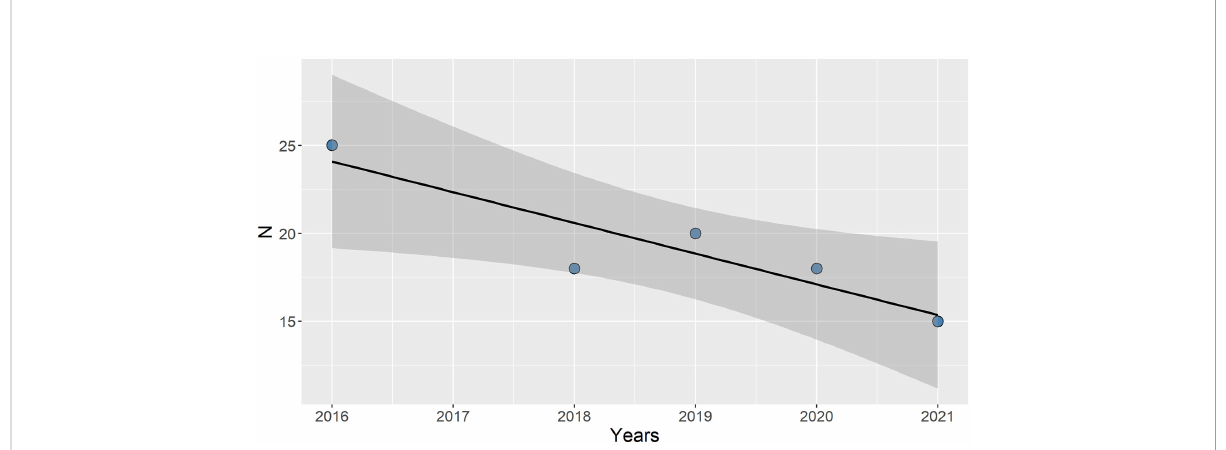
FIGURE 2 Abundance estimates for the common dolphins ’ local population. Estimates of abundance of the common dolphins, including 95% con fi dence intervals, from mark-recapture models applied every year. The presented N is the total abundance after dividing the estimated abundance bythe mark ratio. The linear model is presented on the